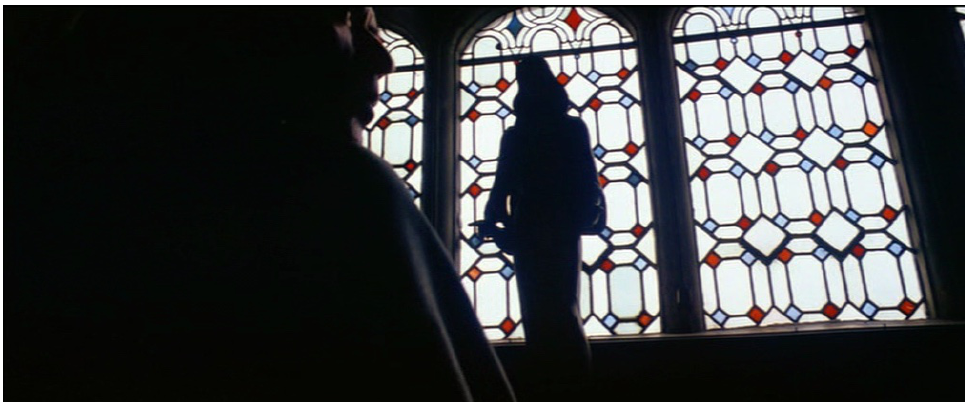
Figure 10: An indigenous tribesman encounters a crucifix outside Jamestown fort.